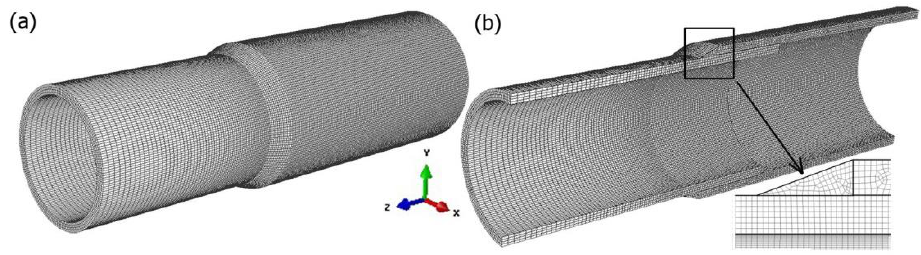
Figure 14. Discrete model of the analyzed joint.